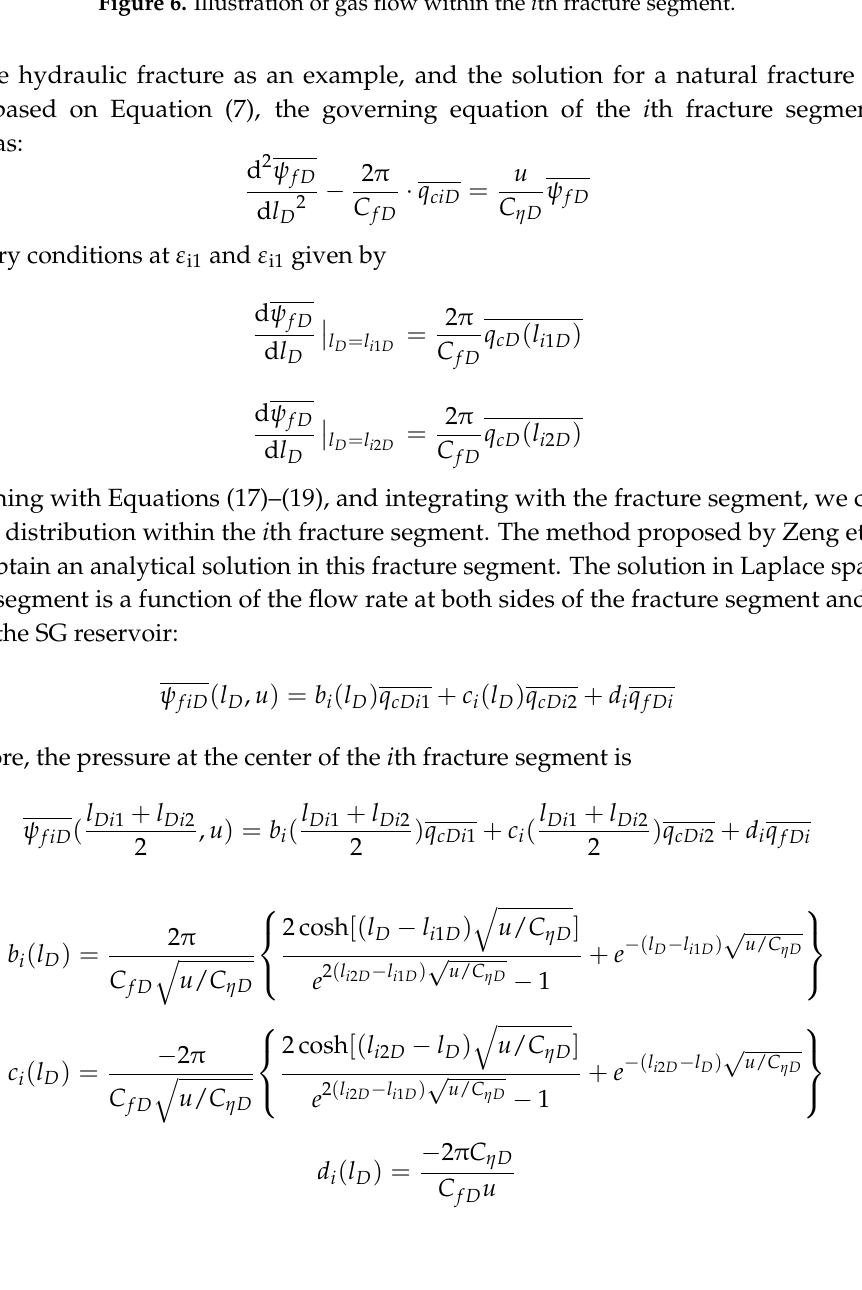
Figure 6. Illustration of gas flow within the i th fracture segment.